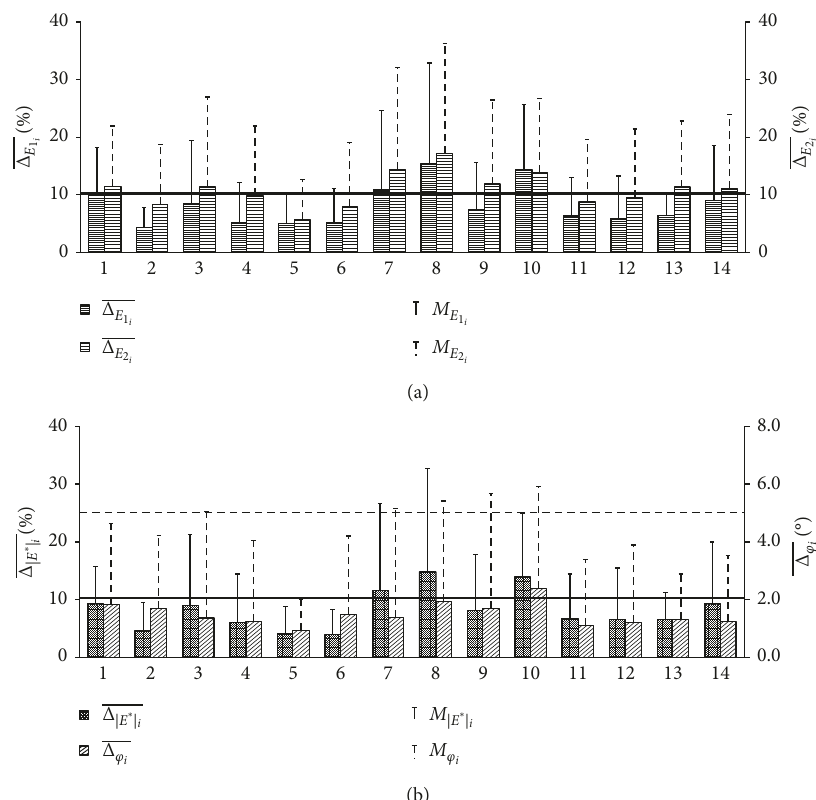
Figure 13: Histograms of global errors of 2S2P1D model fitting of all users for the bituminous mixture (Figure 9), calculated according to equations (38)–(41): (a) relative errors for E 1 and E 2 (